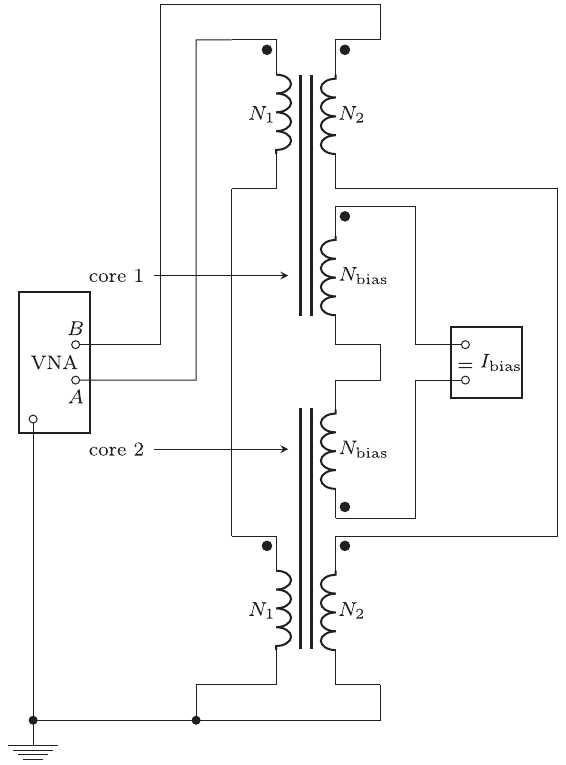
FIG. 5. Circuit diagram for the transmission measurement. The primary winding with N 1 turns and the secondary winding with N 2 turns are connected to ports A and B of the VNA, respectively. The cores under test are biased via N crossed (figure-of-eight) current